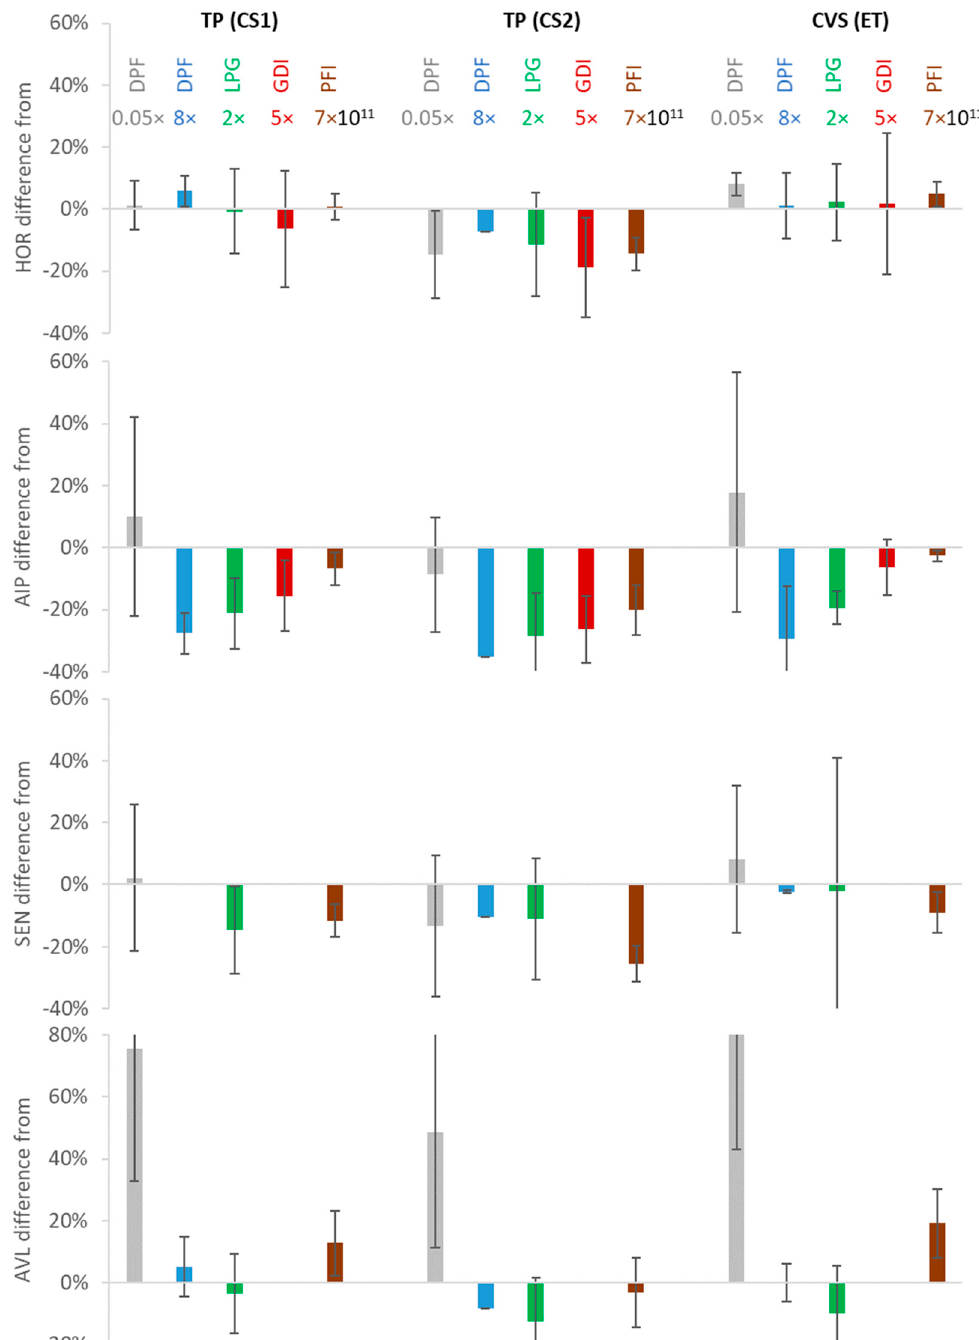
Figure 8. Di ff erences of PEMS from the three reference systems at the tailpipe (TP) and the dilution tunnel (CVS). Error bars show one standard deviation. CS = catalytic stripper; DPF = diesel particulate filter; ET = evaporation tube; GDI = gasoline direct injection; LPG = liquefied petroleum gas; PFI = port fuel